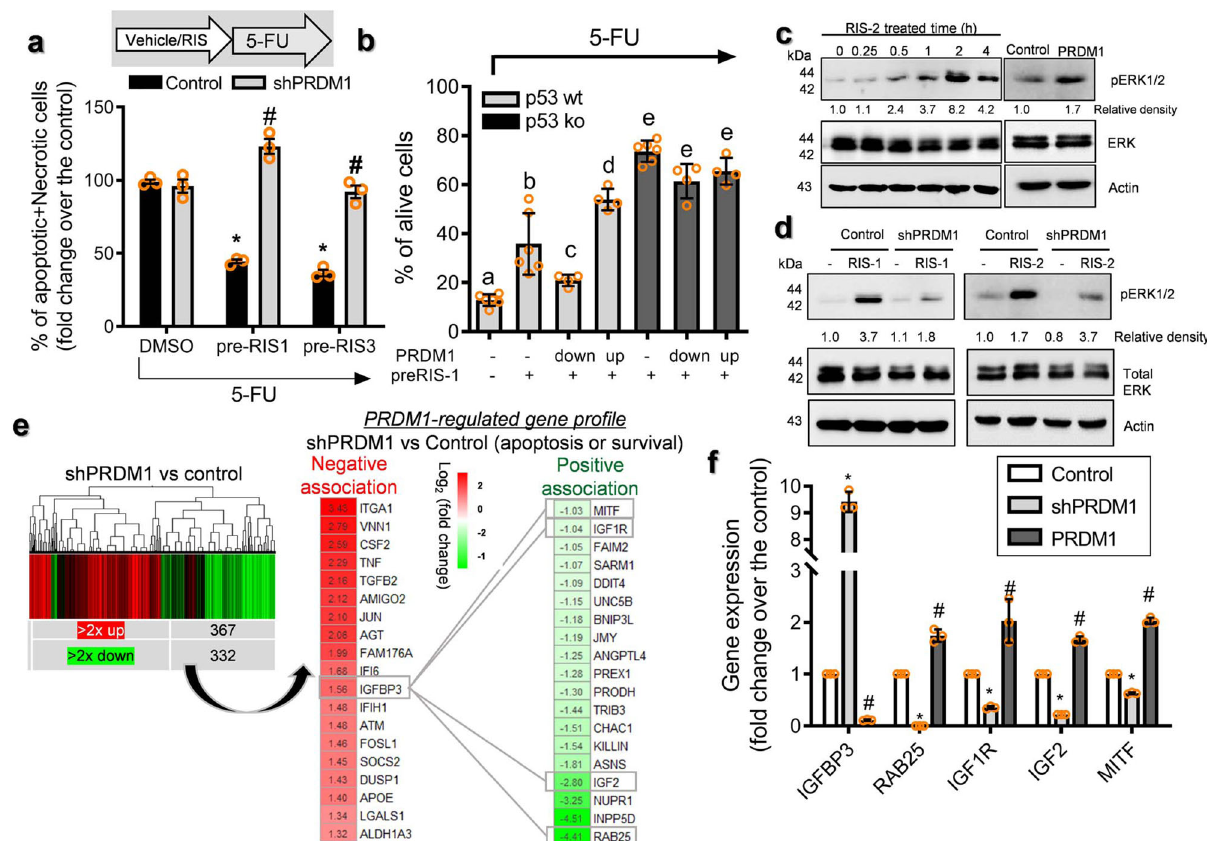
Fig. 5 Roles of PRDM1 in chemoresistance and related signals. a The intestinal cancer cell lines (the negative control plasmid- or shPRDM1-expressing HCT-8) pre-exposed to ID 80 of RIS-1 or RIS-3 for 24 h were treated with 375 μ M 5-FU for 48 h. Results are shown as mean values± SD. Asterisks represent a signi fi cant difference compared to each vehicle (DMSO) treatment group and the symbols (#) indicate a signi fi cant difference compared to each control cells ( n = 3, P < 0.001). b The intestinal cancer cells (the control plasmid-, shPRDM1 or PRDM1-expressing HCT-116) pre-exposed to ID 80 of RIS-1 or RIS-3 for 24 h were treated with 375 μ M 5-FU for 48 h. Alive cells were counted with a hemocytometer and different letters (a – d) over each bar represent signi fi cant differences between groups ( n = 4 – 6, P < 0.05). c HCT-8 cells were treated with ID 90 of RIS-2 for the indicated times and total cell lysates were subjected to western blot analysis. d The intestinal cancer cell lines (the negative control plasmid- or shPRDM1-expressing HCT-8) were treated with ID 90 of RIS-1 for 30 min (the left panels) or ID 90 of RIS-2 for 2 h (the right panel). Total cell lysates were subjected to western blot analysis. e Gene expression pro fi le in cancer cell lines (the negative control vector- or shPRDM1-expressing HCT-8) using comparative cDNA microarray measurements ( n = 3, p < 0.05, left). 2× up or 2× down related genes involved in apoptosis or survival response ( n = 3, P < 0.05, right). f The relative mRNA expressions in cell lines (control plasmid (the negative control shRNA or the empty control pMX-IRES-GFP)-, shPRDM1-, or PRDM1-expressing HCT-8) were quanti fi ed using RT real-time PCR. Results are shown as mean values ± SD. Asterisks or sharps represent a signi fi cant difference ( n = 3, P < 0.05) relative to each control